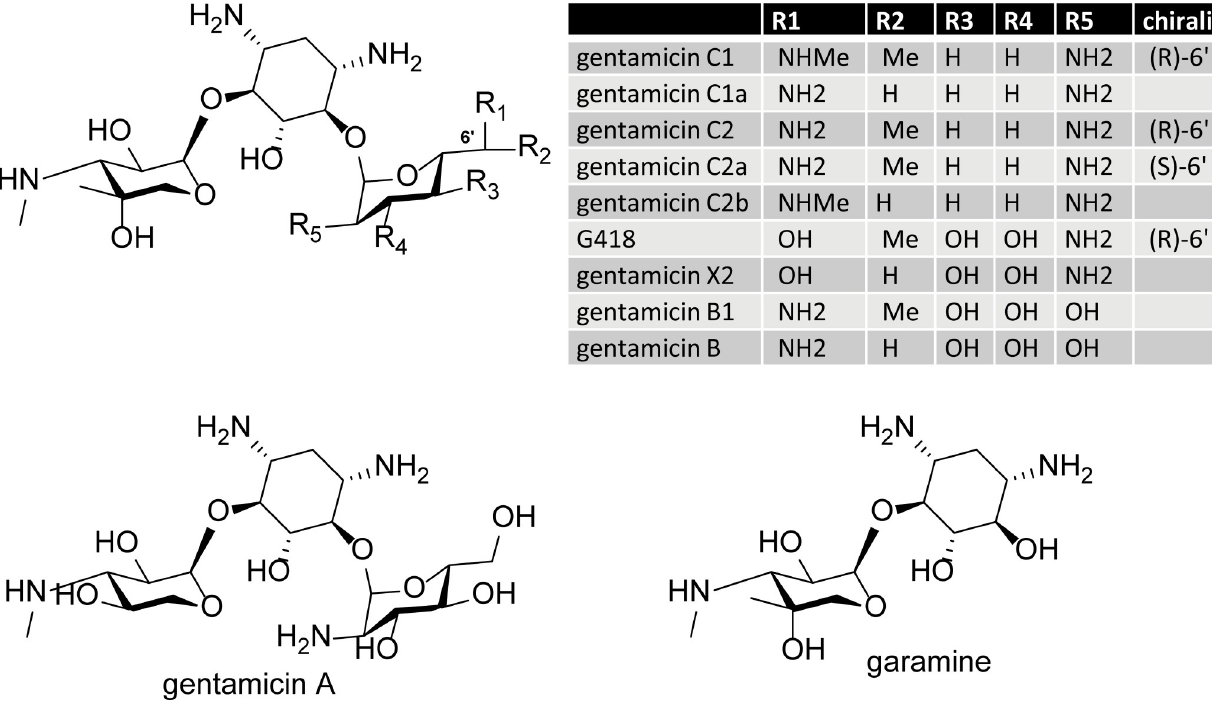
Fig 6. Structure of G418 and gentamicin complex components. The structure on the top left and the table show the structural differences between gentamicin complex components and G418. The structure of the other two gentamicin complex components are shown in the lower two drawings.